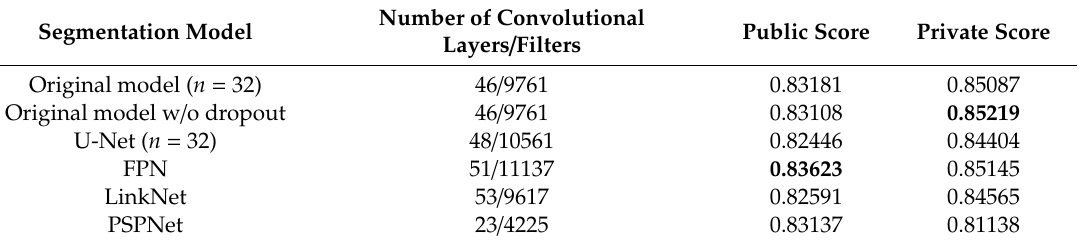
Figure 6. An illustration of the experiment framework based on Yakubovskiy’s segmentation models [48] and input image upscaling. Please note that in the case of PSPNet, due to network limitations, an input size of 120 x 120 (upscaled to 240 x 240) was used. Table 2. A post-completion comparison of different segmentation models.